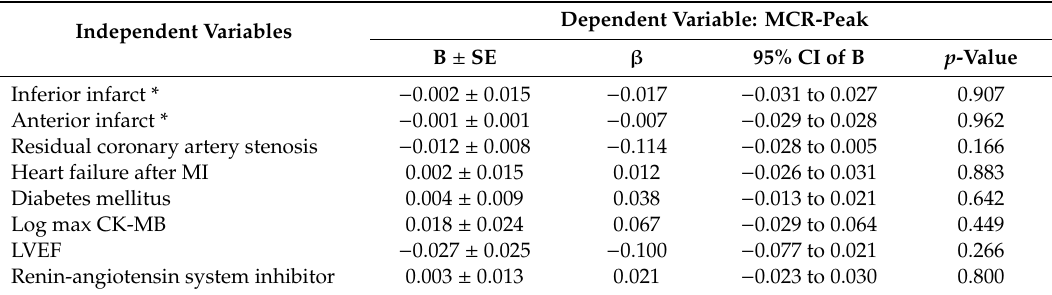
Table 4. Results of multiple regression analysis for the prediction of